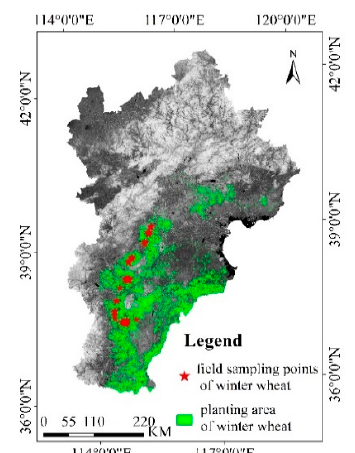
Figure 4. The spatial distribution of the extracted planting location and the field sampling points of winter wheat in the Jing-Jin-Ji (JJJ) region. Table 4. The accuracy of the extracted area of winter wheat in each city (unit: Hectares).